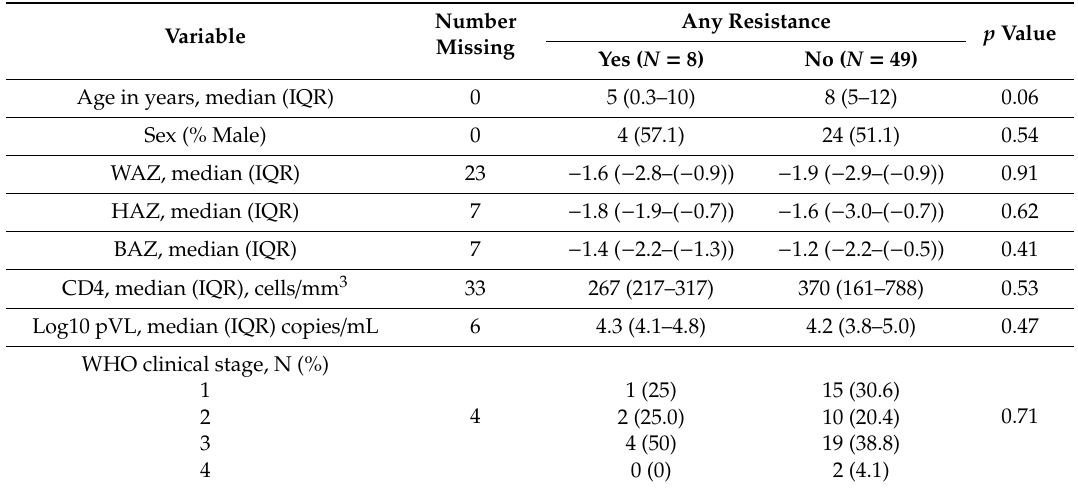
Table 4. Factors associated with PDR among cART-naïve HIV infected children, Ethiopia,